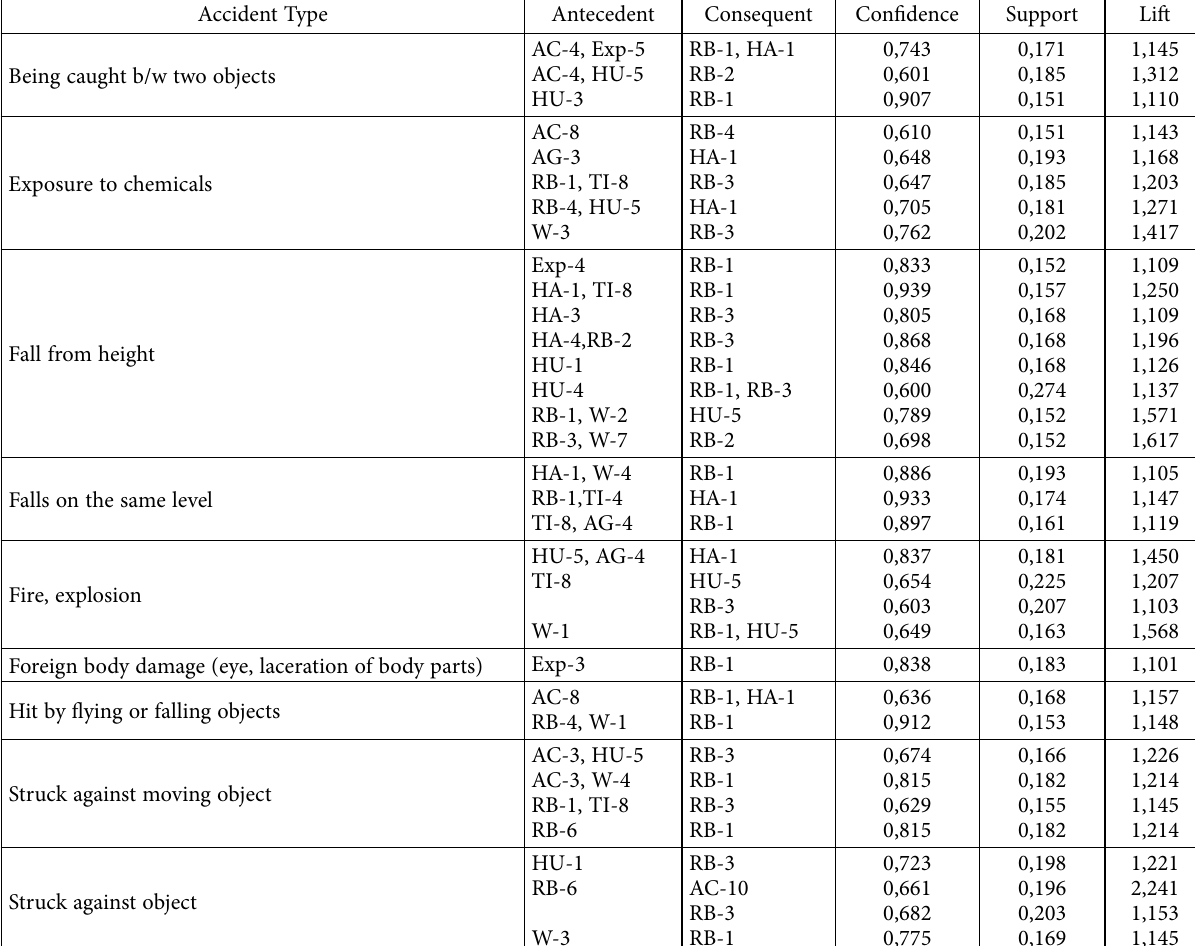
Table 4. Rules generated from the individual ARM analysis for each accident